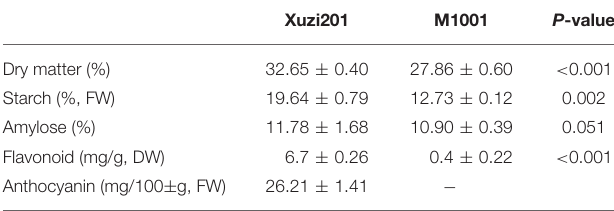
TABLE 1 | Contents of quality parameters of Xuzi201 and